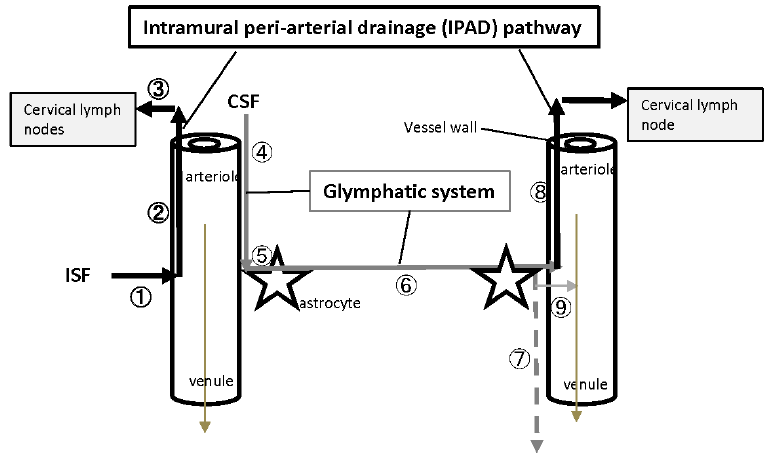
Figure 3. Intramural peri-arterial drainage (IPAD) pathway and glymphatic system in the brain. Clearance of ISF and CSF to the outside of the brain involves both the perivascular IPAD pathway (1,2,3), whereby ISF drains against the blood flow (thinnest brown line in the center of tubes), and paravascular glymphatic system (4,5,6,7), whereby CSF flows in the same direction as blood. Through the IPAD pathway (indicated by thicker solid black lines), ISF (1) flows through the basement membrane of capillary walls, tunica media of arteries, and vessel walls of the internal carotid artery (2), and then drains into the cervical lymph nodes (3). Through the glymphatic system (indicated by thinner gray lines), CSF flows through the para-arterial routes (4), enters interstitial spaces (6) by AQP4-dependent transport through the astroglial cytoplasm (5), flows into the paravenous route (indicated by thinner gray dotted line) (7) or into the perivascular IPAD pathway (8 or 2), and may be drained into the subarachnoid CSF or enter the bloodstream across vessel walls (indicated by thinnest gray line) (9). It is controversial whether or how much the paravenous route (indicated by thinner gray dotted line) (7) is involved in the efflux of toxic intracerebral substances. A critique of the glymphatic system involves the suggested role of AQP4. AQP4 is enriched at CSF interfaces of the brain with expression in astrocytes at the pial surface-facing glia limitans and within perivascular endfeet. It is unclear how perivascular astrocytic AQP4 water channels facilitate a flow of ISF and macromolecules through the brain